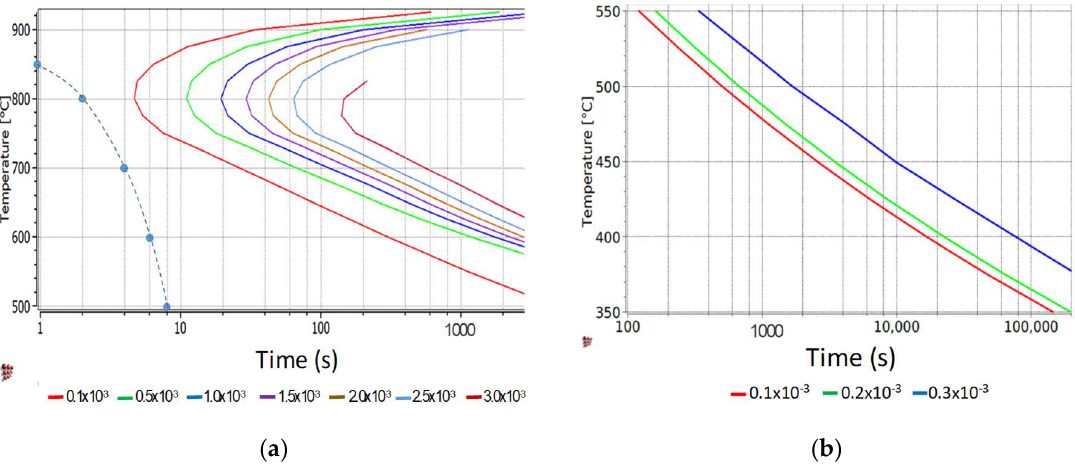
Figure 12. ( a ) V(C,N) PTT in Ref+V ferrite containing 1 × 10 14 /m 2 dislocations and (b ) low temperature PTT for V(C,N) in Ref+V bainitic ferrite containing 5 × 10 14 /m 2